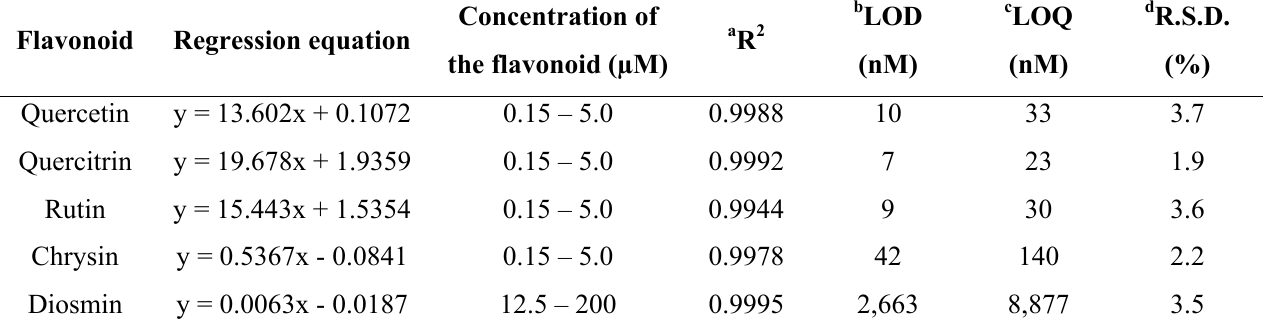
Table 1. Validation data for the determination of flavonoids ( n =